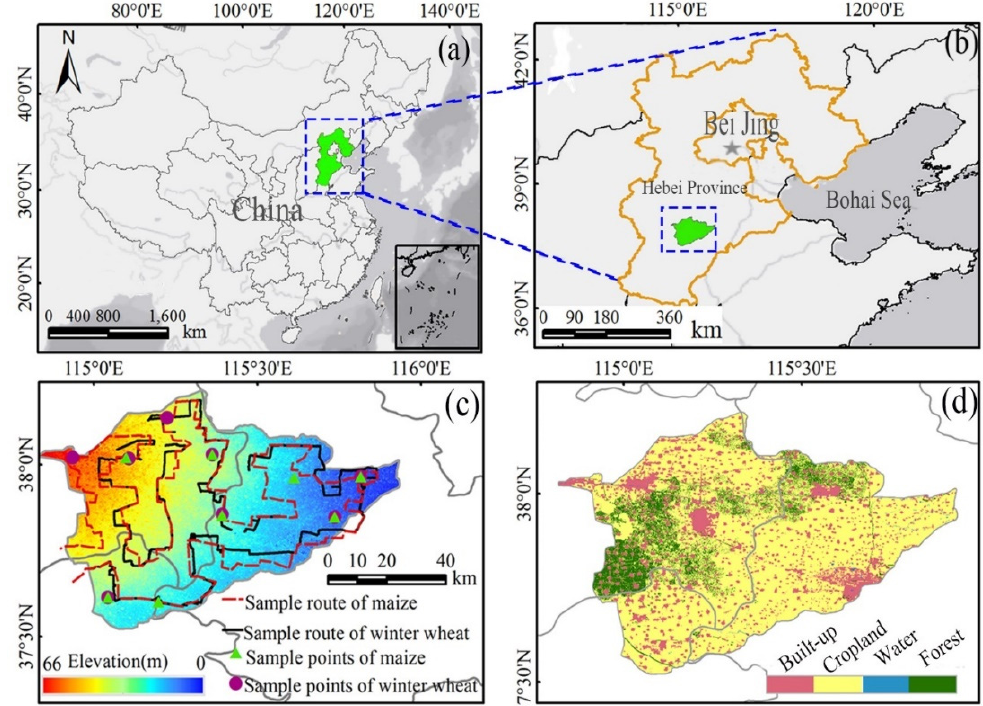
Figure 1. Location of the Shijin irrigation area and the field survey samples. ( a , b ) National and provincial boundaries. ( c ) Sample routes and elevation. ( d ) Land use for irrigation.